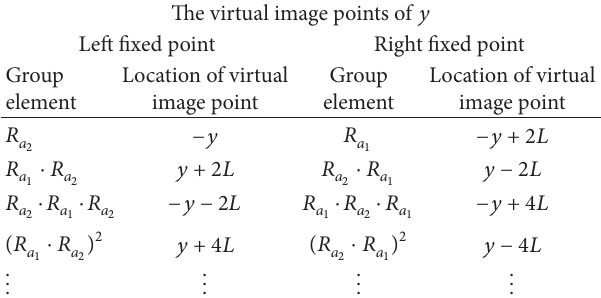
The virtual image points of